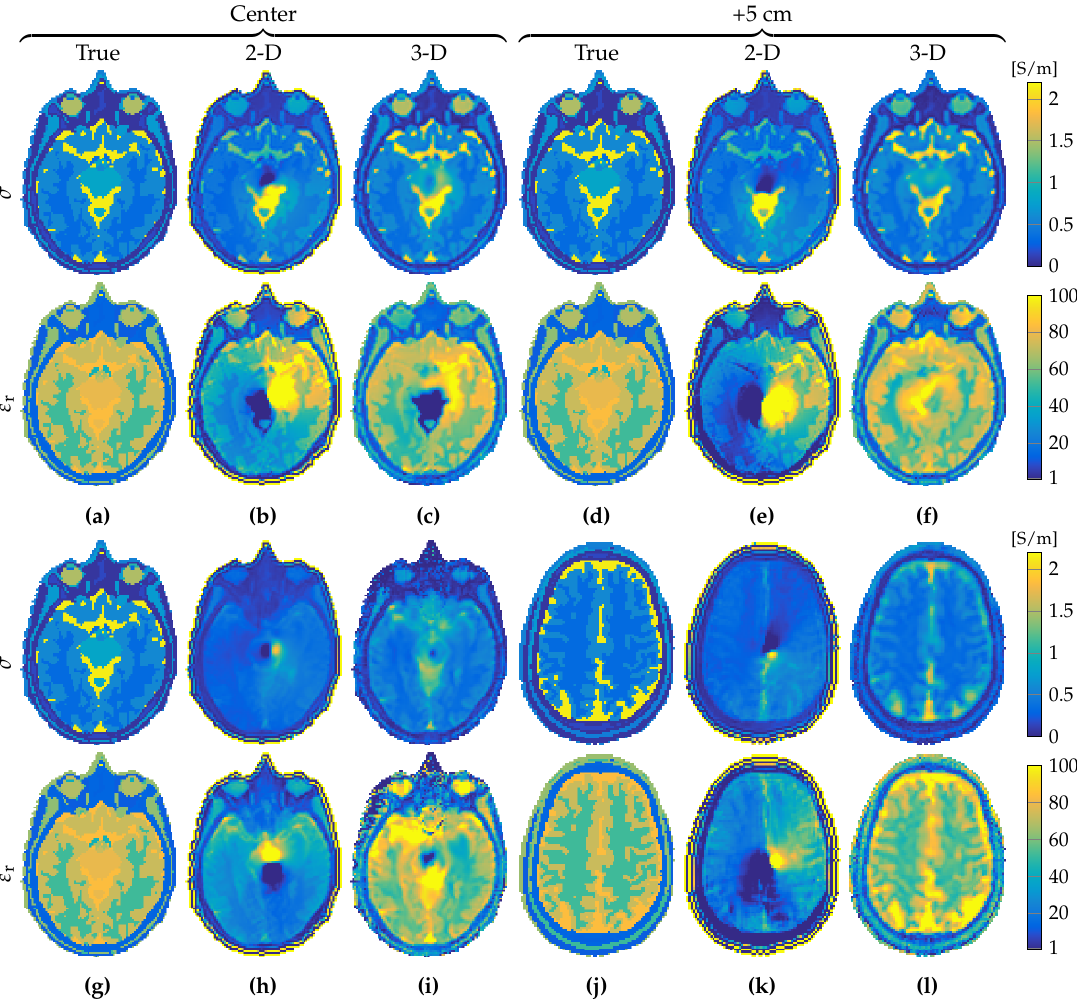
fields after 5000 and 1